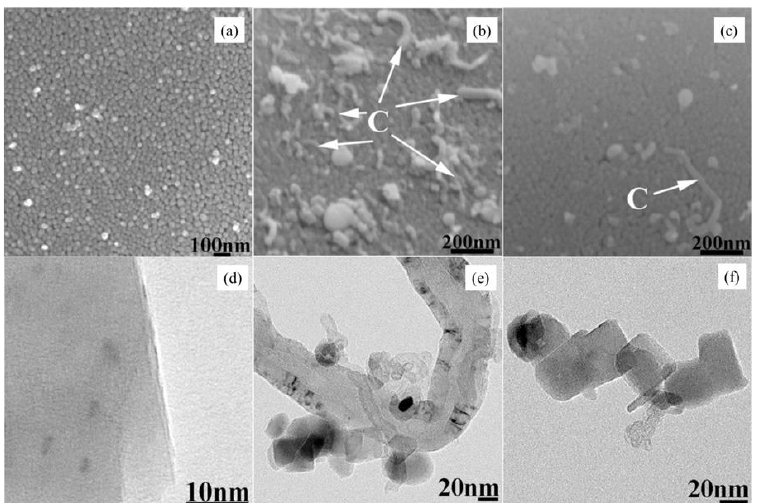
Figure 18. ( a – c ) SEM and ( d – f ) TEM micrographs of pure Co-MgO and used Co-MgO after reforming reaction in a conventional fluidized bed reactor and a magnetic-assisted fluidized bed (MFB) reactor. Reprinted from [115]. Copyright (2018), with permission from Elsevier.